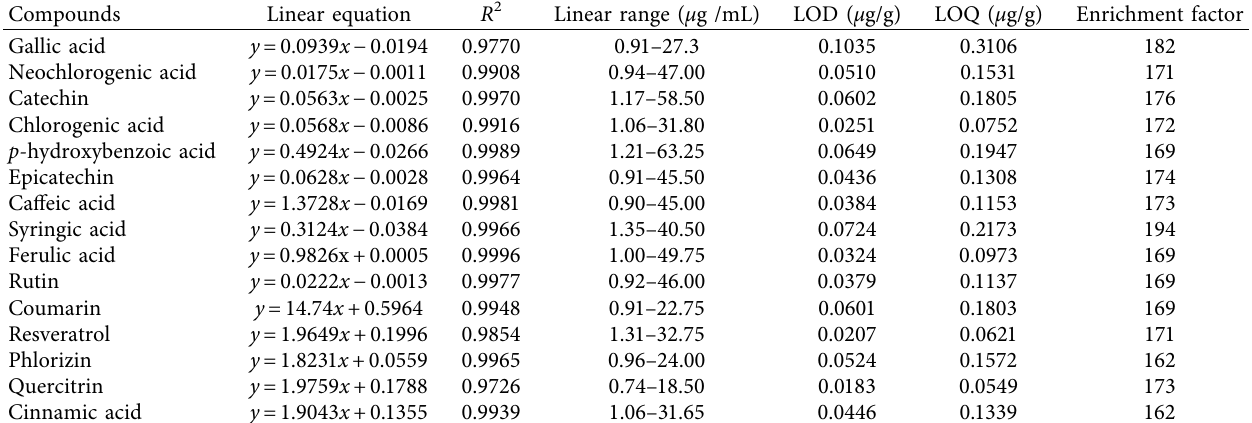
Table 2: Analytical performance data of 15 phenolic compounds by DLLME-UPLC-MS/MS.